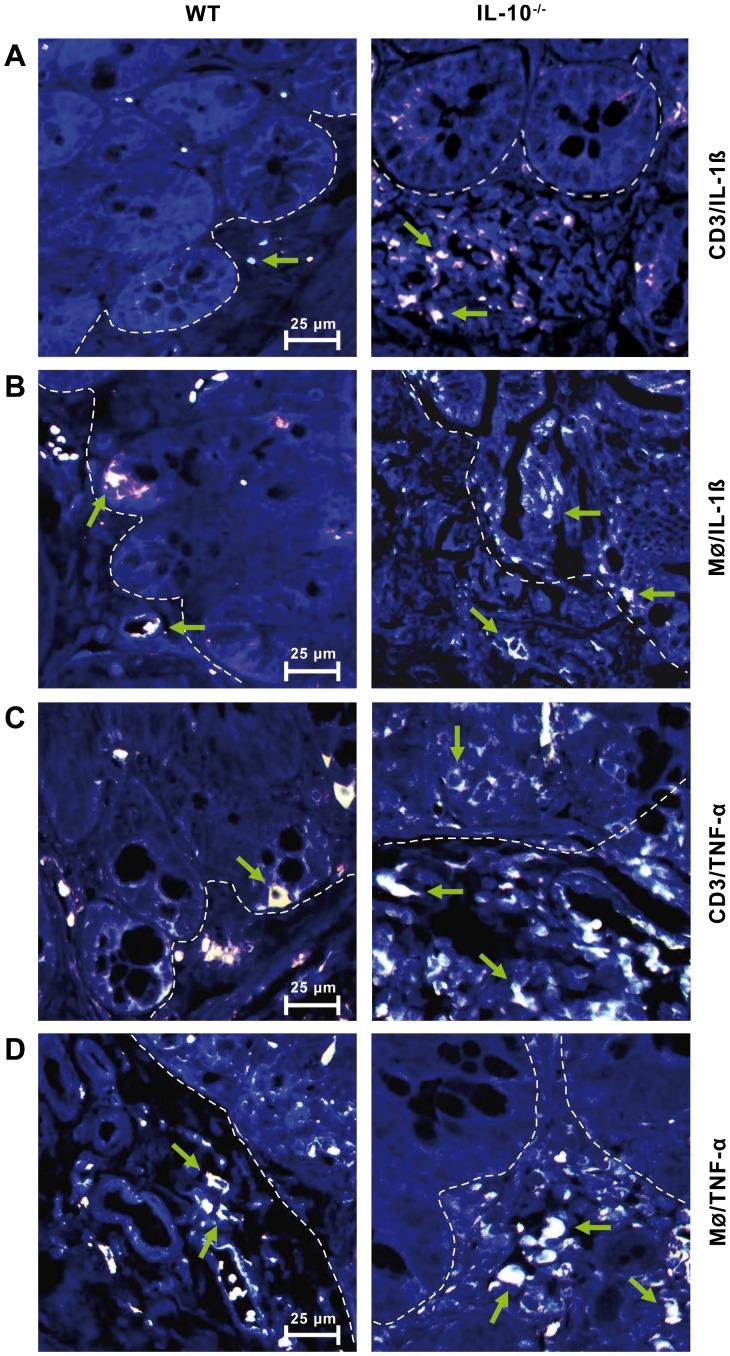
Double immunofluorescence staining of the proinflammatory cytokines IL-1β and TNF-α in infiltrating CD3 T-lymphocytes and macrophages.IL-10−/− mice showed signs of inflammation with strong accumulation of CD3 T-lymphocytes and macrophages (Mø) in the mucosal and submucosal layer in the colon with high expression of the proinflammatory cytokines IL-1β and TNF-α. Only single-cytokine–positive CD3 T-lymphocytes and macrophages were observed in the layers of the colon from WT mice. The dashed line separates the epithelial layer from the connective tissue of the submucosal layer. Double immunofluorescence staining presents as mostly white in the overlay (instead of yellow) as an amalgamation of green and red due to the background staining with DAPI (blue). Representative cells are marked with arrows. Shown are representative images of three independent experiments.